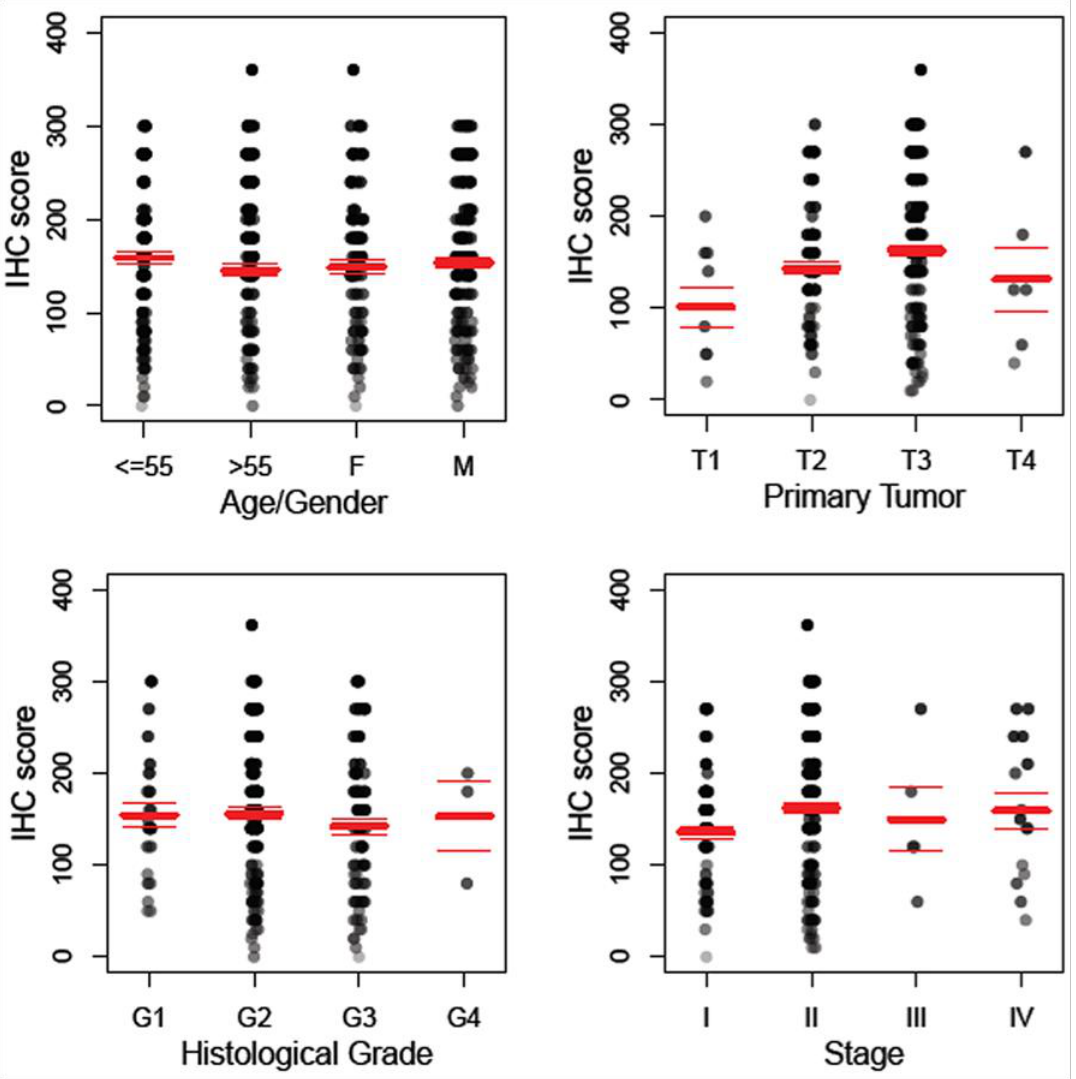
Figure 4. Anti-TRPM8 immunoreactivity in pancreatic adenocarcinoma positively correlates with primary tumor size and stages. The distribution of the IHC score for expression of TRPM8 is displayed against age/gender, histological grade, primary tumor (T), and stage. The total number of specimens of pancreatic adenocarcinoma examined is 280. Polyserial correlation between the primary tumor size (T) or the tumor stages and the log-transformed IHC score is 0.13 and 0.10,